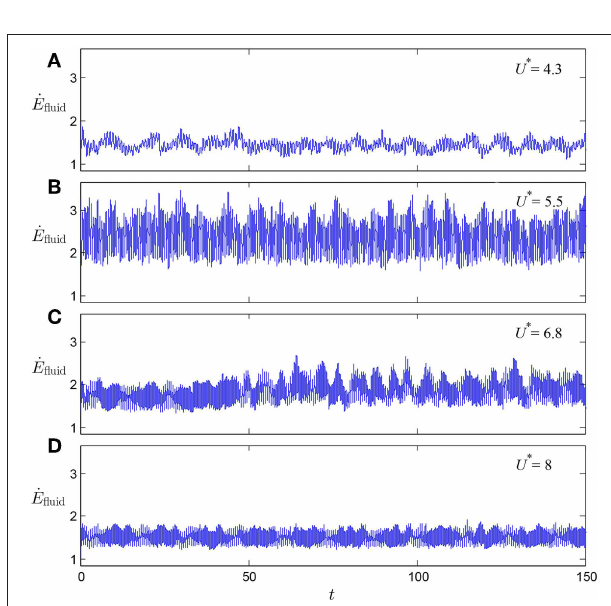
FIGURE 12 | Time series of the rate at which energy is dissipated in the fluid at different reduced velocities: (A) U ∗ U ∗ 8. =